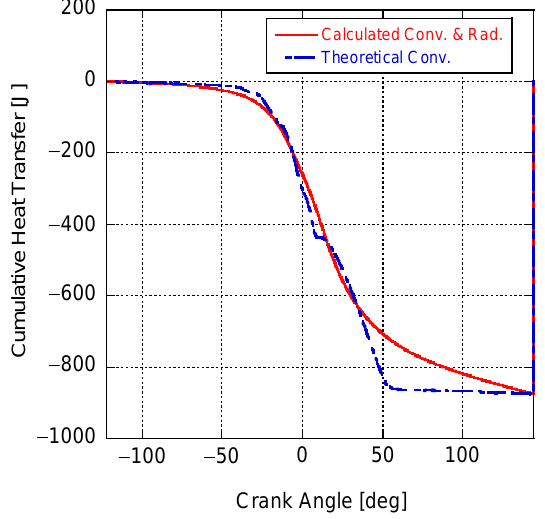
Figure 10. Comparison between the calculated convective and radiative cumulative heat transfer and the theoretical convective only heat transfer that would result using the heat release calculated through the change in chemical species.